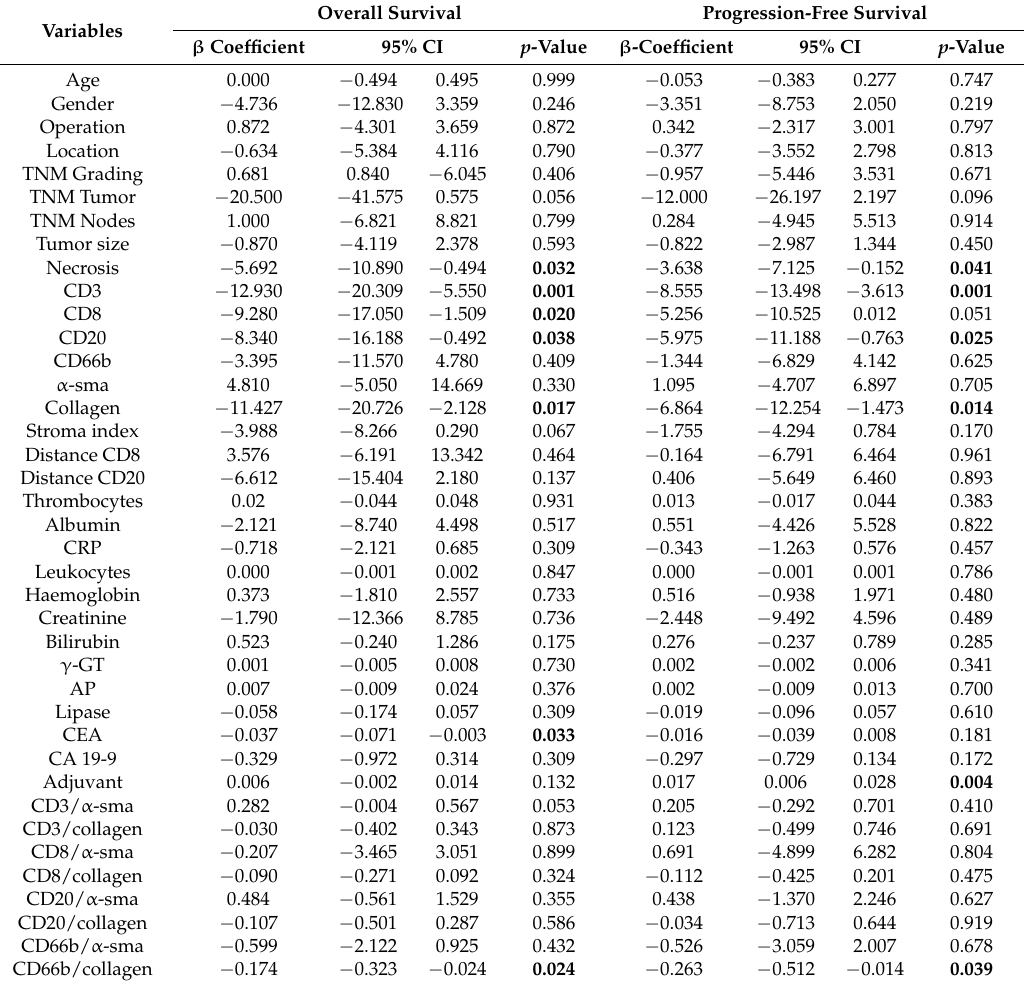
Table 4. Univariate analysis in a linear regression of all independent variables on overall survival (OS) and progression-free survival (PFS) as dependent variables.